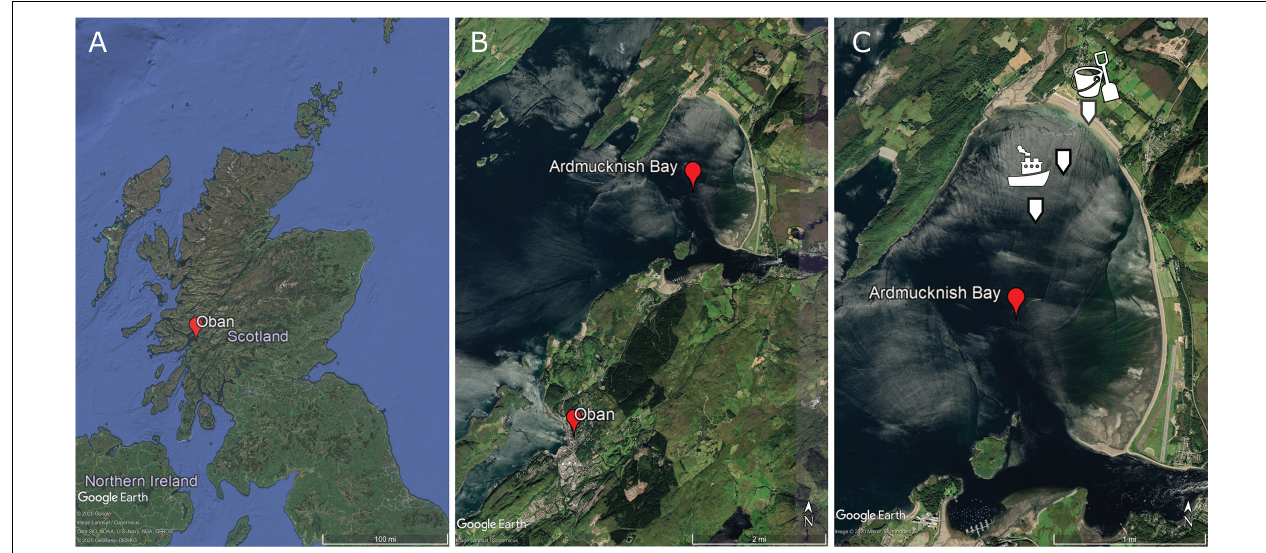
FIGURE 3 | (A) Sampling site location within Scotland. (B) Close up view of Ardmucknish Bay north of Oban, Scotland. (C) Location of the three sites is indicated with white arrows. Pictograms illustrate the mode of sampling; the boat represents the sampling with the Van-Veen grab. ©Google Earth.